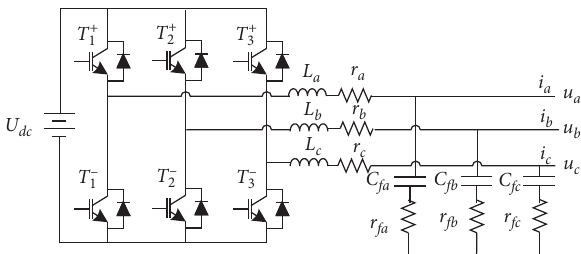
Figure 3: Circuit topology of the ESS in ESS-integrated PV/wind